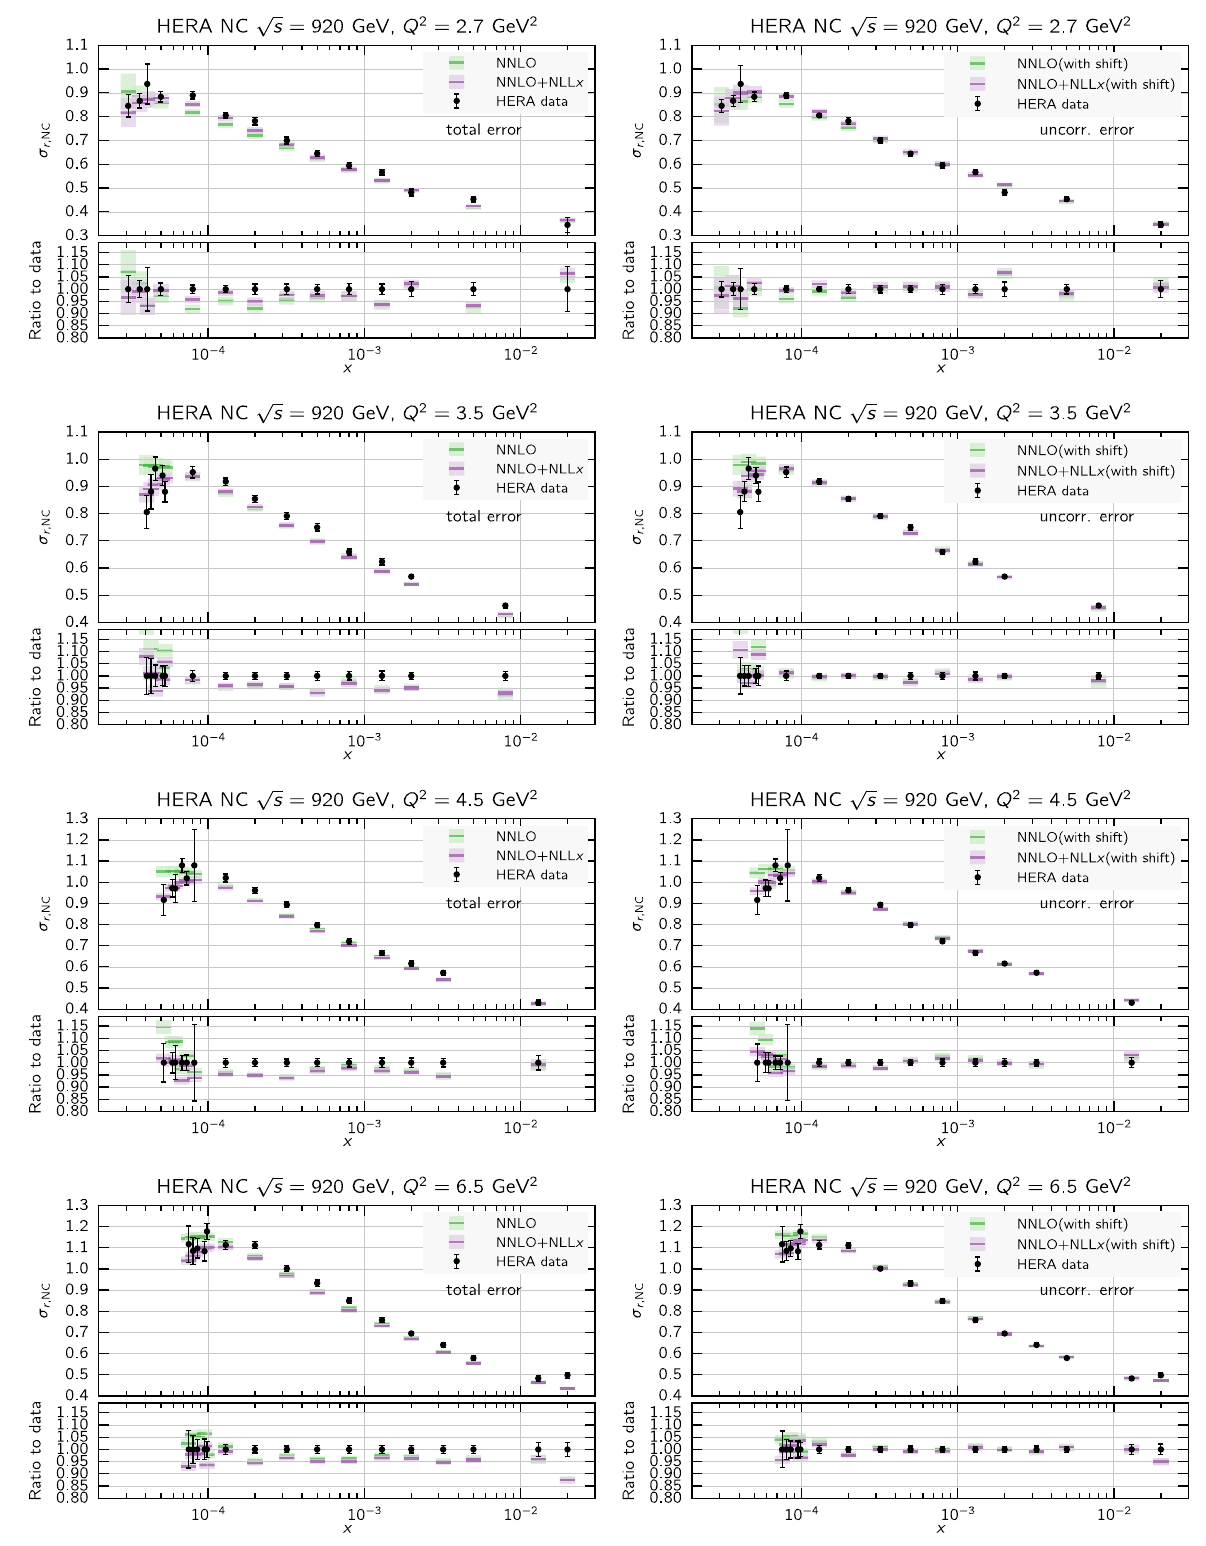
Fig. 20 Comparison between the HERA NC reduced cross-section For each bin we also show in the bottom panel the ratio of the theory √ s = 920 GeV dataset and the results of the NNLO and from the predictions to the experimental data. The plots on the right show the NNLO+NLL x fits with the corresponding PDF uncertainties. We show theoretical prediction including the shifts as discussed in the text the results for the first four bins in Q 2 above the Q 2 kinematic cut. min